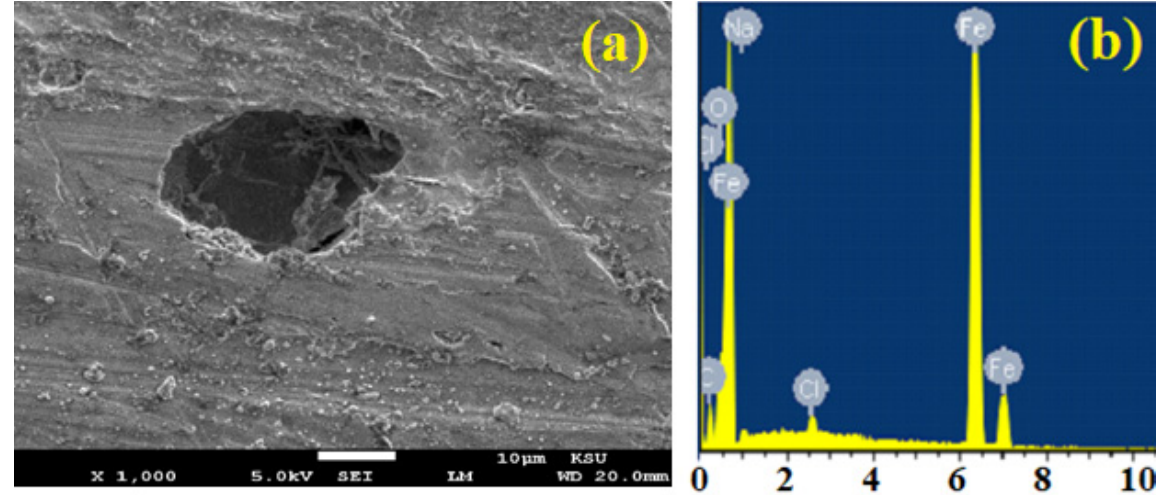
Figure 6. ( a ) SEM image and ( b ) EDX profile spectrum after 1 h holding the potential at − 475 mV (Ag/AgCl) for the surface of the iron rod that was immersed for 48 h in 3.5% NaCl solution.